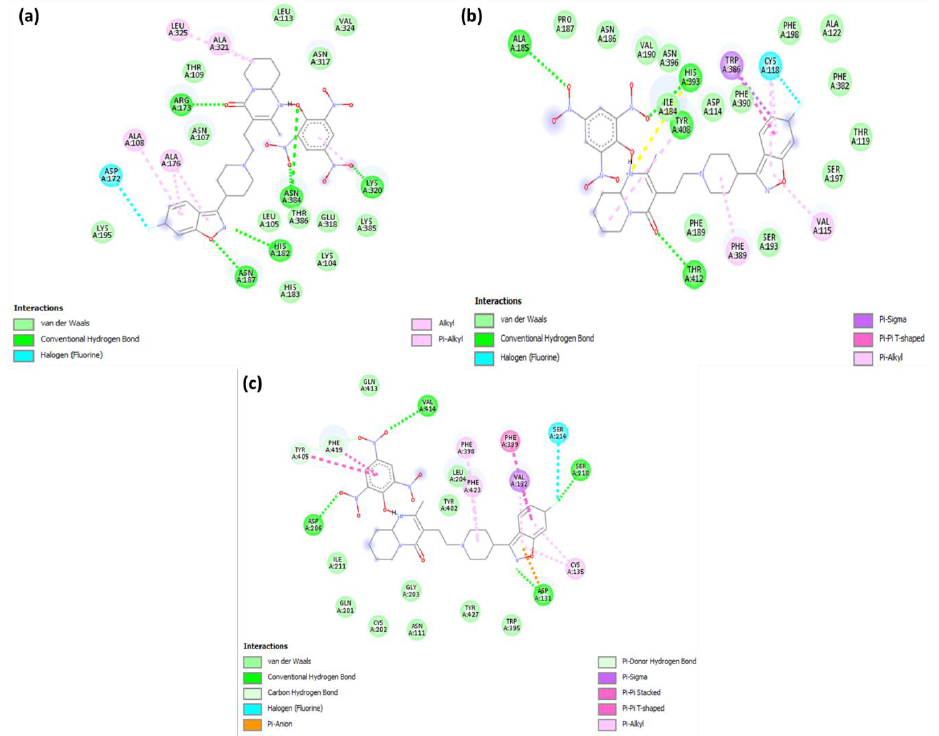
Figure 7. 2D representations of interactions between CTcS complex and ( a ) serotonin, ( b ) dopamine, and ( c ) adrenergic receptors.